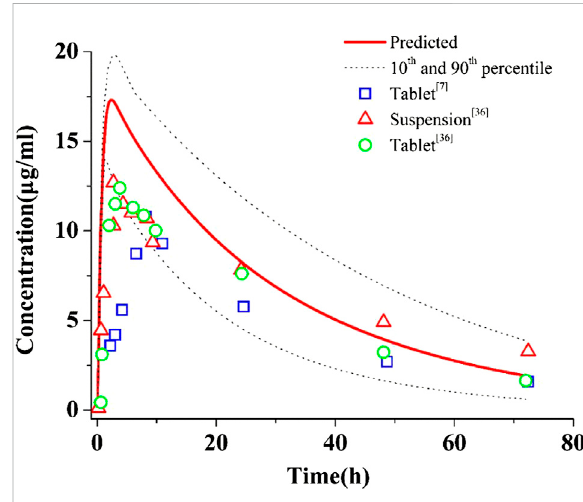
FIGURE 2 Simulations of pharmacokinetics of PAZ in humans after an oral administration of 400 mg single dose. The blue squares ( □ ), red up-triangles ( △ ) and green circles ( ○ ) refer to clinically measured pharmacokinetic data of PAZ tablet and suspension from references 7 and